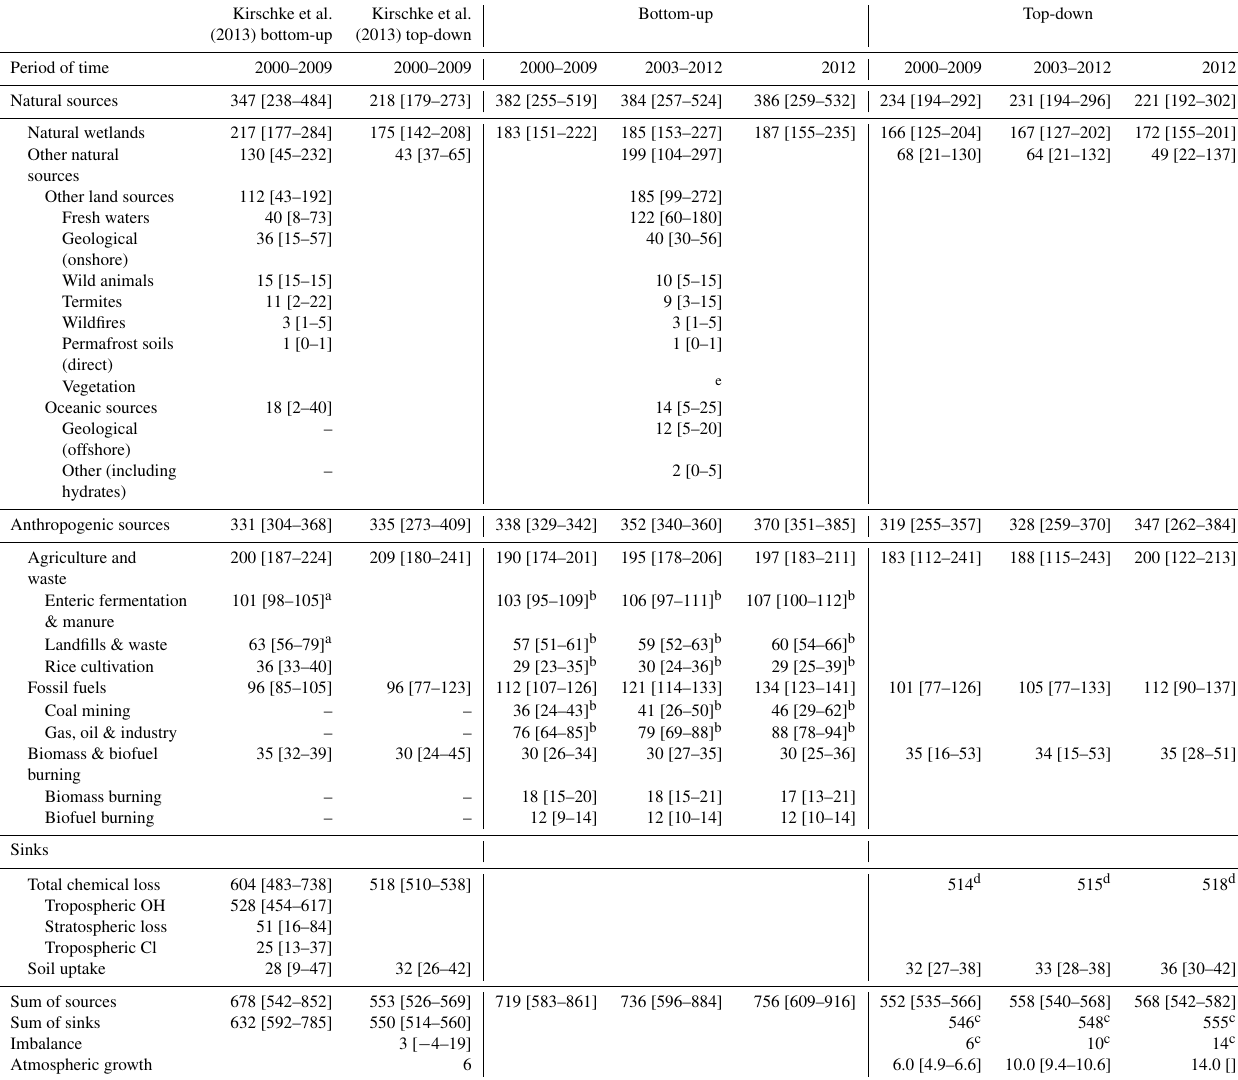
Table 2. Global methane emissions by source type in TgCH 4 yr − 1 from Kirschke et al. (2013) (left columns) and for this work using bottom-up (middle column) and top-down (right columns). As top-down models cannot fully separate individual processes, only emissions for five categories are provided (see text). Uncertainties are reported as [min–max] range of reported studies. Differences of 1TgCH 4 yr − 1 in the totals can occur due to rounding errors. Kirschke et al. Kirschke et al. Bottom-up Top-down (2013) bottom-up (2013)